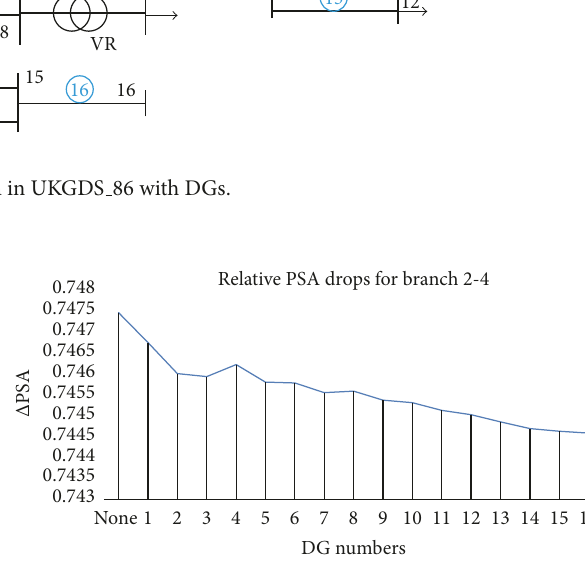
Branches near power distribution station still need more attention for security.